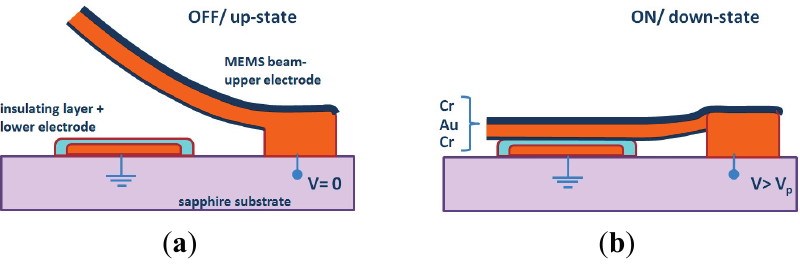
Figure 8. Cross sectional view of a cantilever-type beam RF-MEMS showing the two states: ( a ) non-actuated up-state; ( b ) actuated down-state when the applied voltage is higher than the MEMS pull-down voltage ( V p ). From [21], reprinted with